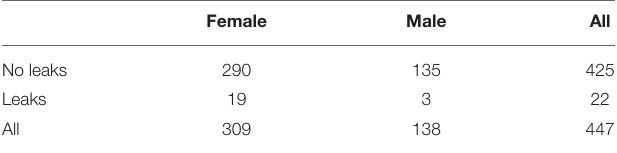
TABLE 4 | Correlation of metric variables and leakage.